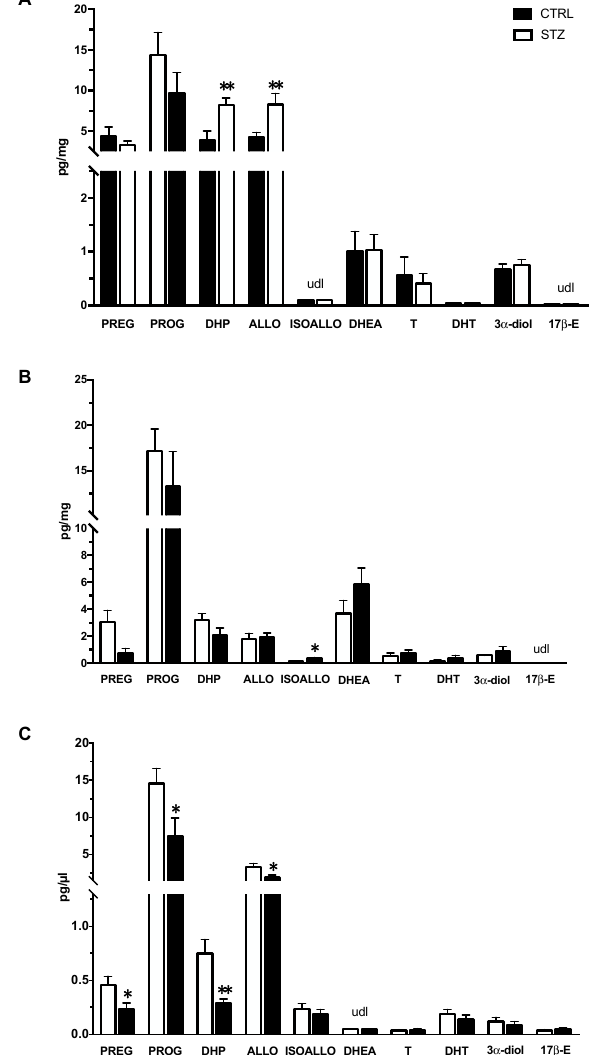
Figure 5. Effect of one month of diabetes on the levels of neuroactive steroids in the hippocampus, cerebral cortex and plasma of female non-diabetic control (CTRL; n = 7) and diabetic (STZ; n = 7) rats. Levels of neuroactive steroids in hippocampus (panel A ), cerebral cortex (panel B ) and in plasma (panel C ). Data are expressed as pg/mg ± SEM in case of brain areas, and pg/ μ L ± SEM in case of plasma. u.d.l. = under detection limit. Detection limits were 0.02 pg/mg or pg/ μ L for testos- terone (T) and 17 β -Estradiol (17 β -E), 0.05 pg/mg or pg/ μ L for pregnenolone (PREG), progesterone